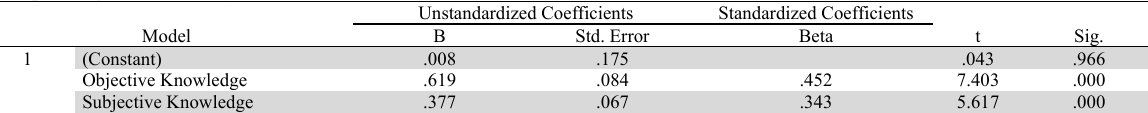
Multiple Regression